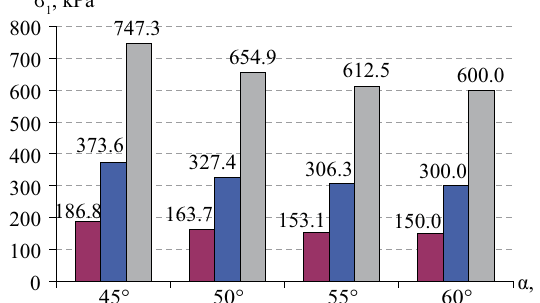
Fig. 2. Influence of failure plane inclination versus vertical component of stresses: ■ – σ 3 = 50 kPa; ■ – σ 3 = 100 kPa;